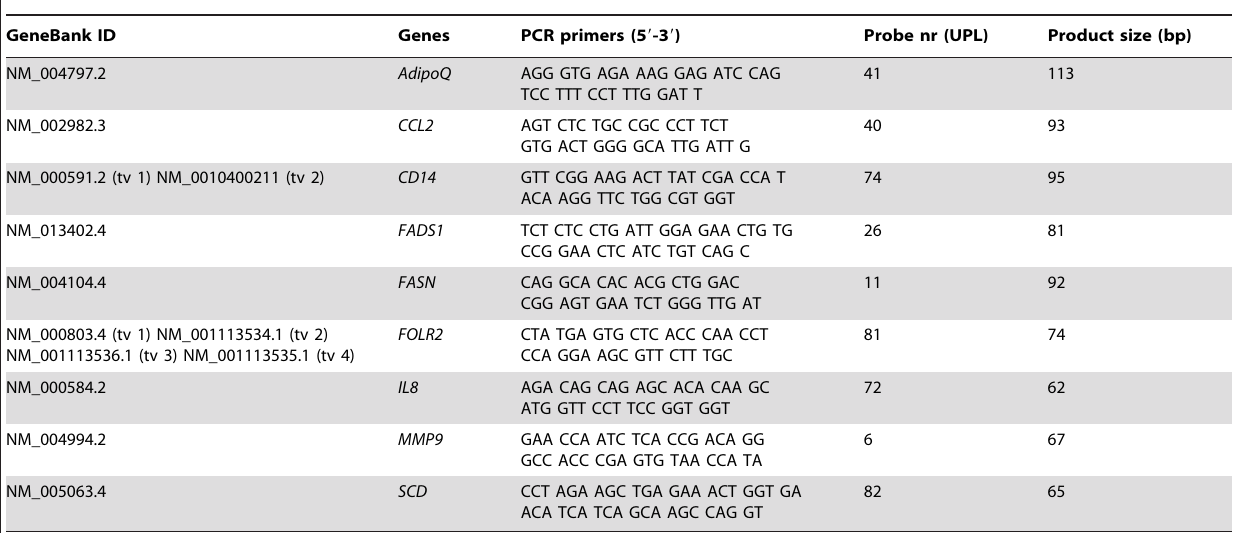
Table 1. Primers used in this